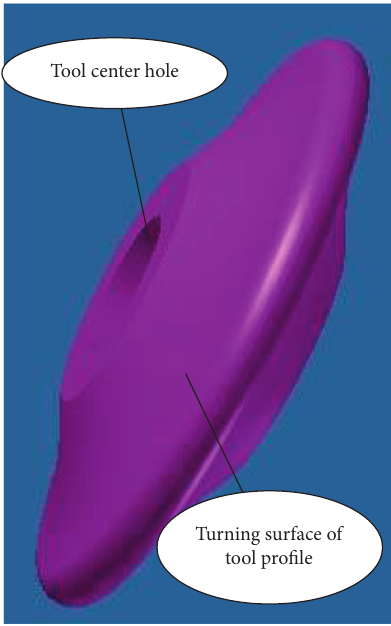
Figure 3: Shape of disc milling